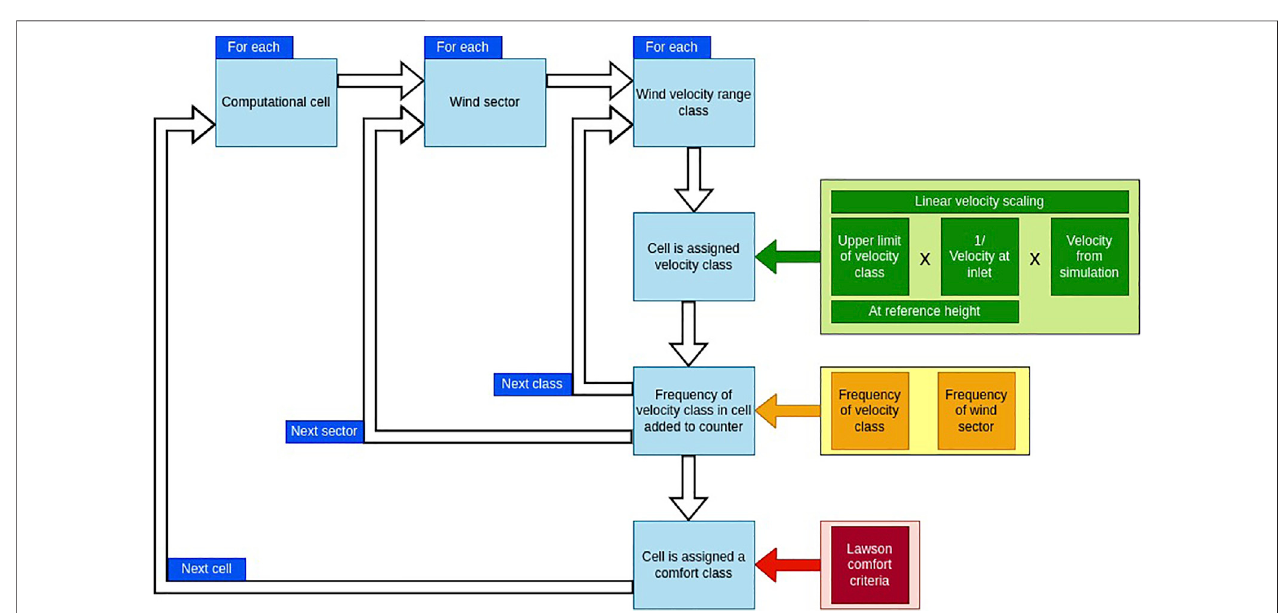
FIGURE 3 | Outline of the algorithm used to calculate pedestrian wind comfort.